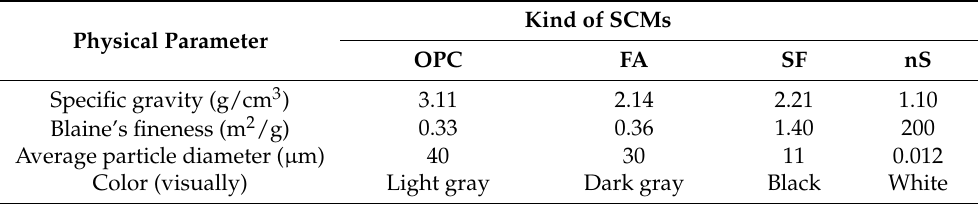
Table 5. Physical characteristics of SCMs used.